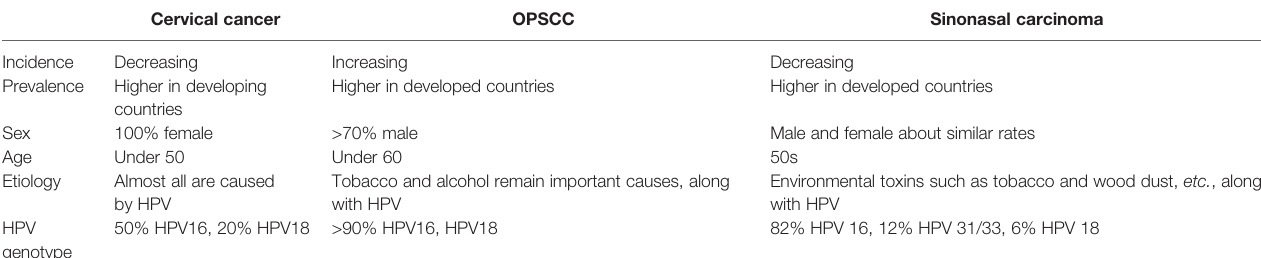
TABLE 1 | Epidemiology summary of HPV-associated cervical cancer, OPSCC and sinonasal carcinoma. Cervical cancer OPSCC Sinonasal carcinoma Incidence Decreasing Increasing Decreasing